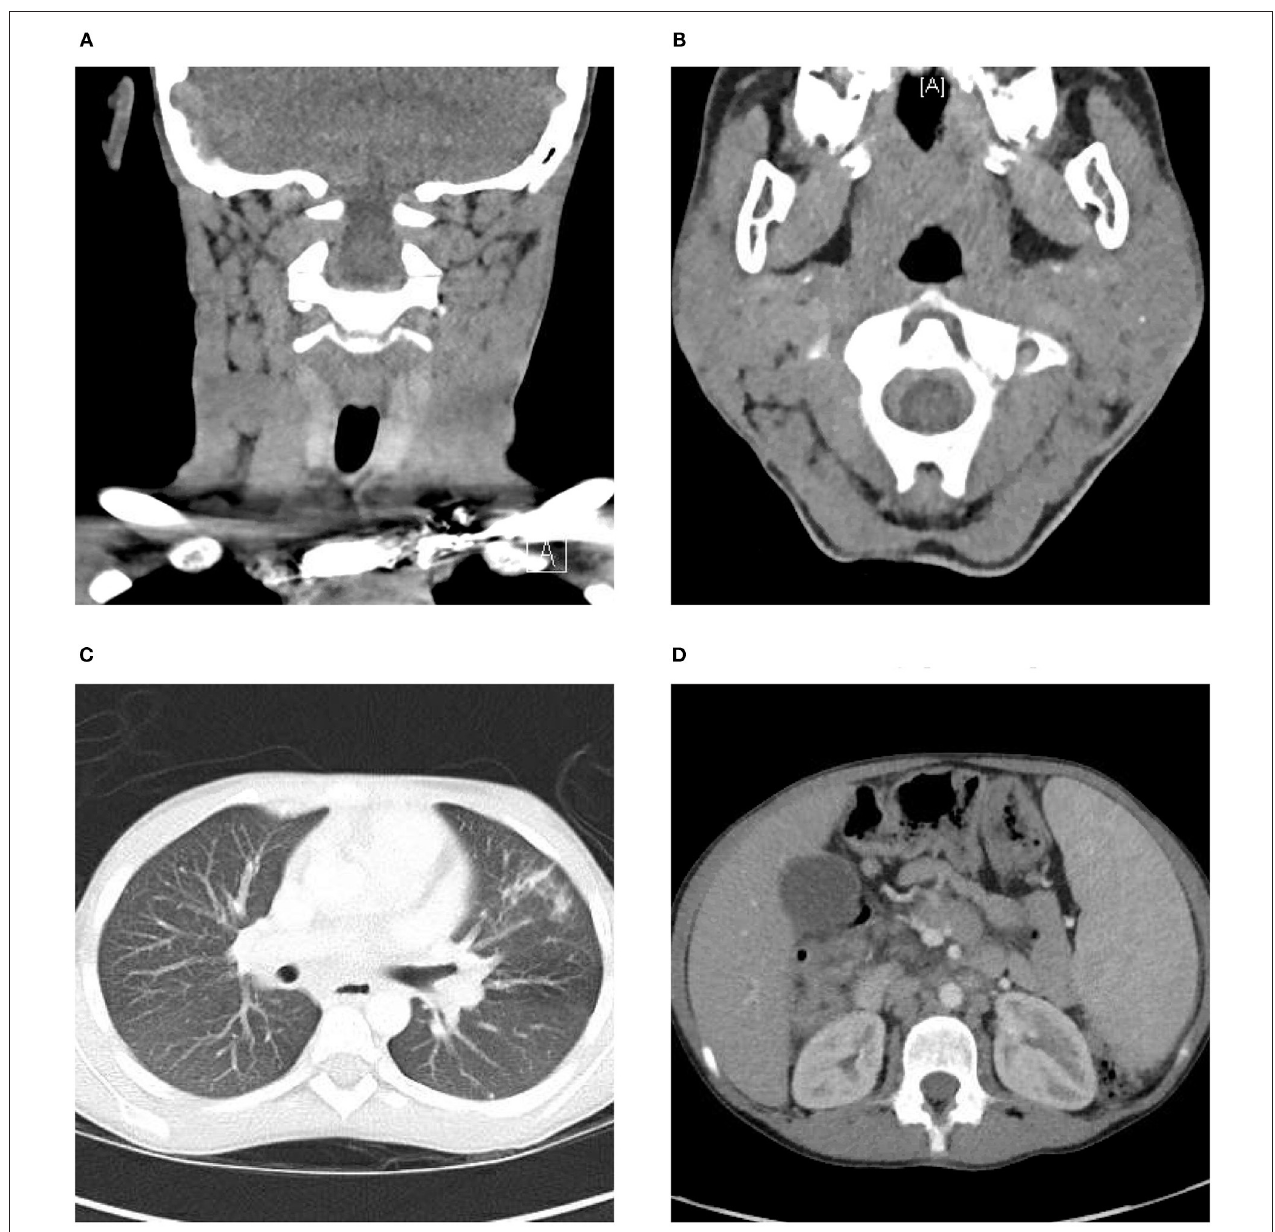
FIGURE 2 | CT head and neck, chest, abdomen, and pelvis. (A) CT demonstrating left greater than right scattered cervical lymphadenopathy. (B) Bilateral parotid gland enlargement, left greater than right. (C) Mediastinal and hilar lymphadenopathy, multiple calcified and noncalcified lung nodules, lung cysts, and bronchiectasis. (D) Hepatosplenomegaly, abdominal and pelvic lymphadenopathy as well as marked thickening of the distal through terminal ileum wall and the wall of the cecum extending up to the hepatic